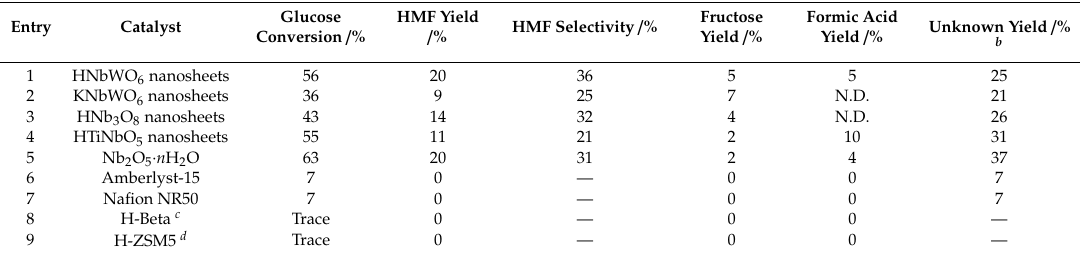
Table 2. Formation of 5-hydroxymethylfurfural (HMF) from glucose in water over several solid acid catalysts a.